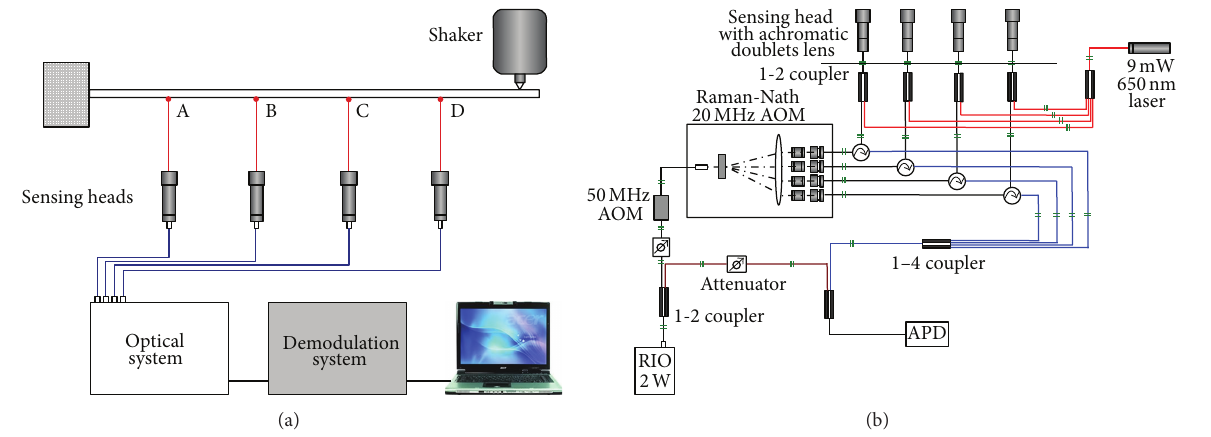
Figure 13: Schematic layout of (a) 4-point laser Doppler vibrometer and (b) its optical